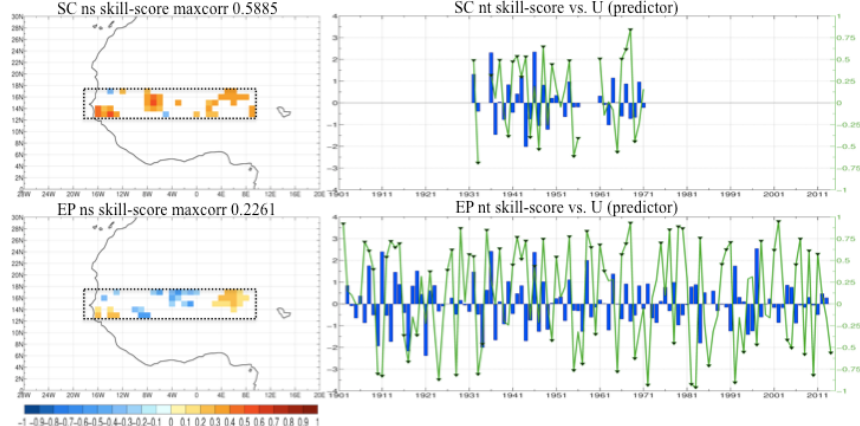
Figure 5. Skill-score validation using Pearson correlation coefficients between observations and hindcasts. Left column corresponds to the spatial validation for each point in space. Right column corresponds to validation time series (green line) between hindcasts and observations considering only the regions indicated by positive significant spatial correlation. Period SC (top panels) and EP (bottom panels). Significant correlation values for time series are indicated by shaded triangles. Blue bars correspond to the expansion coefficient ( U ) of the SSTA (predictor). Significant values are plotted from a 90% statistical significance under a Monte Carlo test.